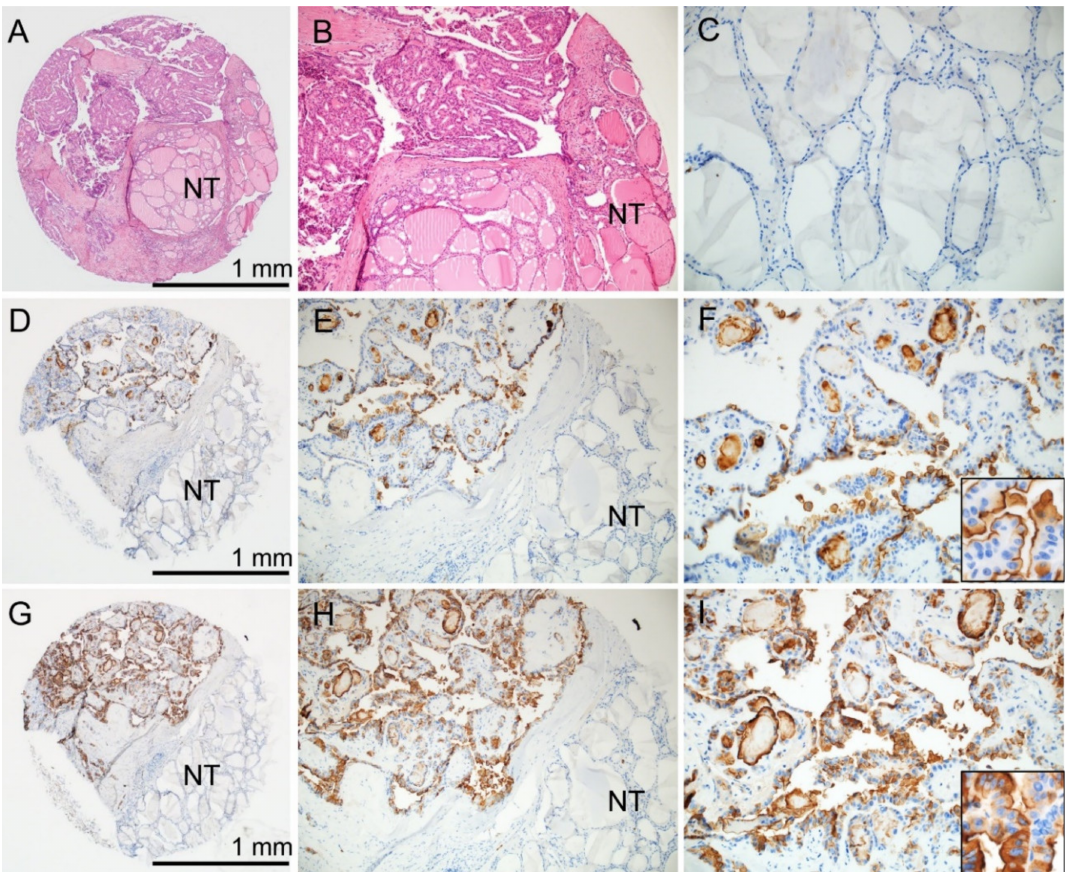
Figure 1. Immunohistochemical staining for CD10 and CD15 on the tissue microarray of papillary thyroid carcinoma. ( A ) The tissue core contains tumor and non-tumor (NT) areas (hematoxylin and eosin stain). ( B ) The higher power view of the tissue core shows papillary thyroid carcinoma and NT adjacent to tumor. ( C ) NT in the same case is negative for both CD10 and CD15. Tumor cells in the same case are positive for both CD10 ( D – F ) and CD15 ( G – I ) immunostaining. ( F ) Inset shows CD10 staining at the apical surface of tumor cells. (I) Inset shows CD15 cytoplasmic and